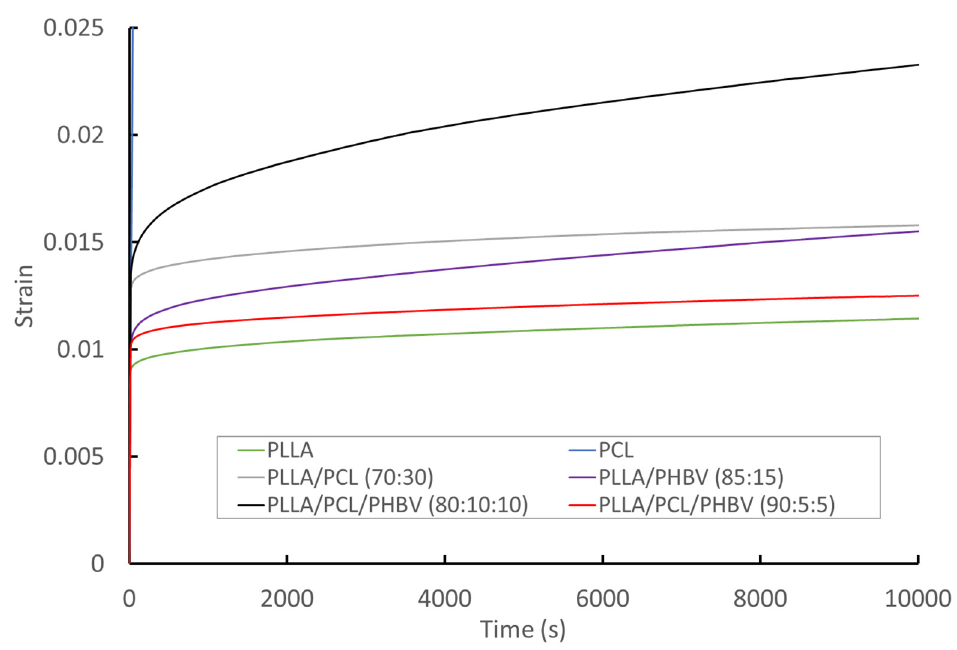
Figure 5. Representative time–strain curves for polymers and blend filaments under a 40 N constant load. Table 4. Average creep rate at room temperature under a 40 N constant load, and measured viscosity at 210 °C.